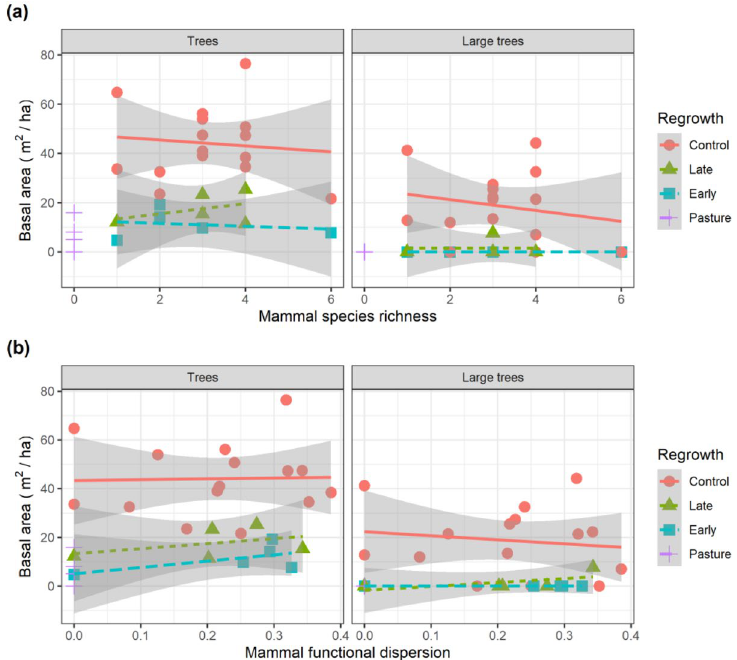
Figure 4. Mammal diversity and basal area across a lowland forest regrowth gradient. The basal area of ( a ) all and ( b ) large living trees were recorded together with the diversity (species richness and functional dispersion) of terrestrial mammals in 30 plots (15 control and 15 regrowth). Lines and shaded areas are mean values and 95% confidence intervals from linear models illustrating trends in basal area with increasing mammal diversity. Points with different shapes represent different regrowth plot